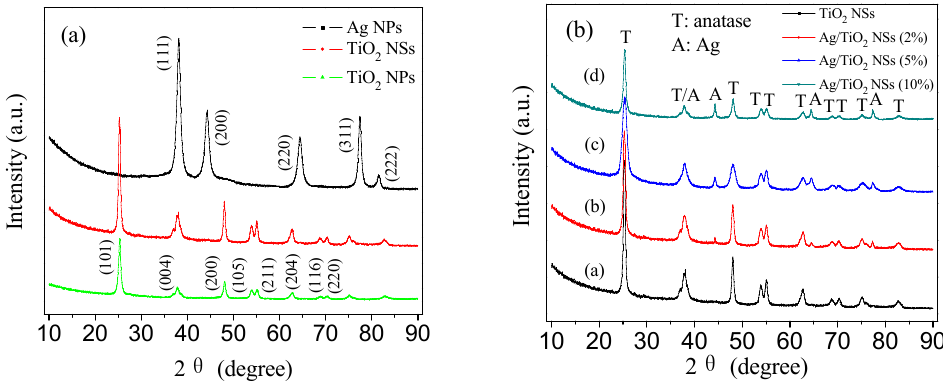
Figure 3. XRD patterns of pure catalysts ( a ) and Ag/TiO 2 NSs catalysts ( b ).